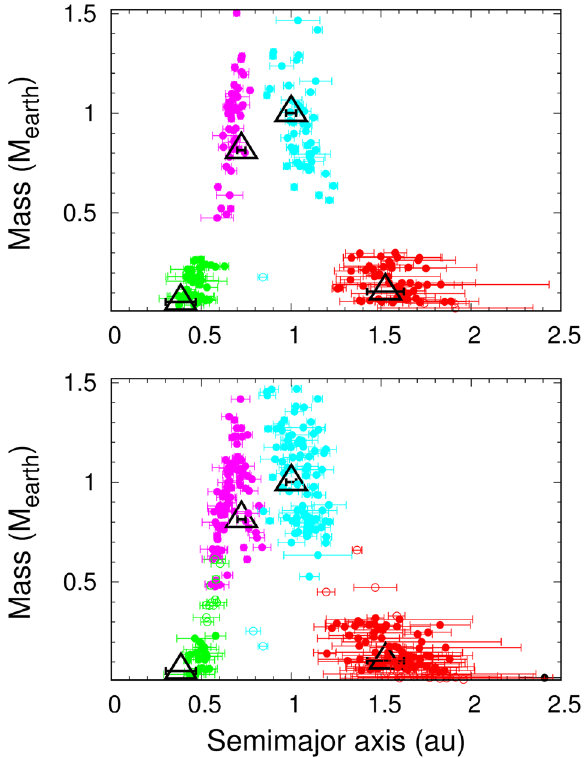
Figure 3. Planets formed in 47 four-planet systems obtained from all simulations (top) and in analogue systems containing three or four representative terrestrial planets from simulations of the standard disk (bottom). Planet analogues of Mercury, Venus, Earth and Mars are indicated by green-, magenta-, cyan- and red-filled symbols, respectively. The error bars indicate the variation in heliocentric distance based on the object’s perihelion and aphelion. The large open triangles represent the terrestrial planets of the solar